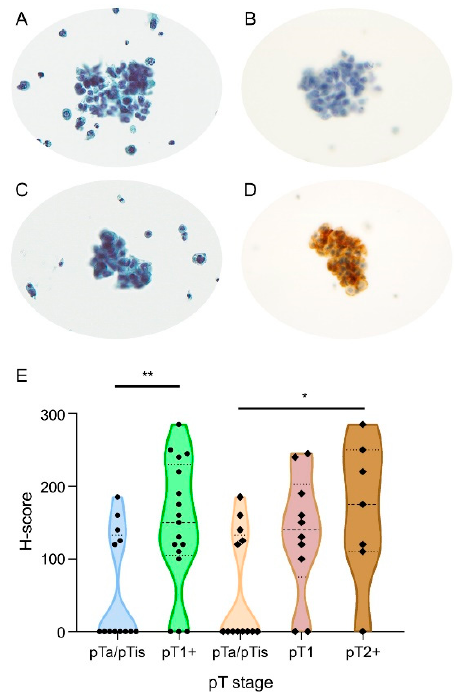
Figure 6. Immunocytochemical (ICC) verification of moesin ( MSN ) as a predictive biomarker for invasive bladder urothelial carcinoma (BUC) in liquid-based cytology (LBC) samples. ( A – D ) Representative BUC and moesin ICC images on LBC: ( A ) BUC LBC image, ( B ) matched ICC image (negative staining), ( C ) BUC LBC image, ( D ) matched ICC image (positive staining). ( E ) Moesin ICC positivity among non-invasive BUC (NIBUC) (pTa / pTis), stromal-invasive BUC (SIBUC) (pT1), and muscle-invasive BUC (MIBUC) (pT2 + ) (statistical significance, * p -value < 0.05; ** p -value < 0.01; pT, pathologic T; pTa, non-invasive papillary carcinoma; pTis, urothelial carcinoma in situ; pT1, tumor invades lamina propria (subepithelial connective tissue); pT2 + , tumor invades muscularis propria and beyond). Table 1. Correlation between moesin immunocytochemistry (ICC) and invasion depth of bladder urothelial carcinoma (BUC).